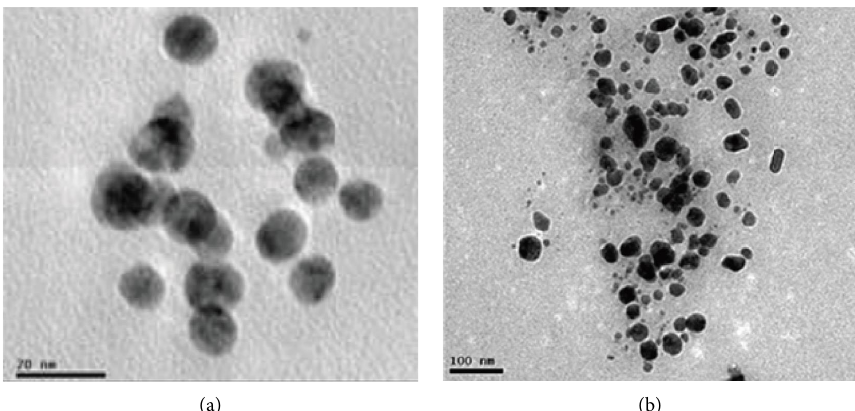
Figure 4: HR-TEM images for (a) AgNPs synthesized from seed extracts of W. tinctoria and (b) AgNPs synthesized from stem extracts of A. catechu .